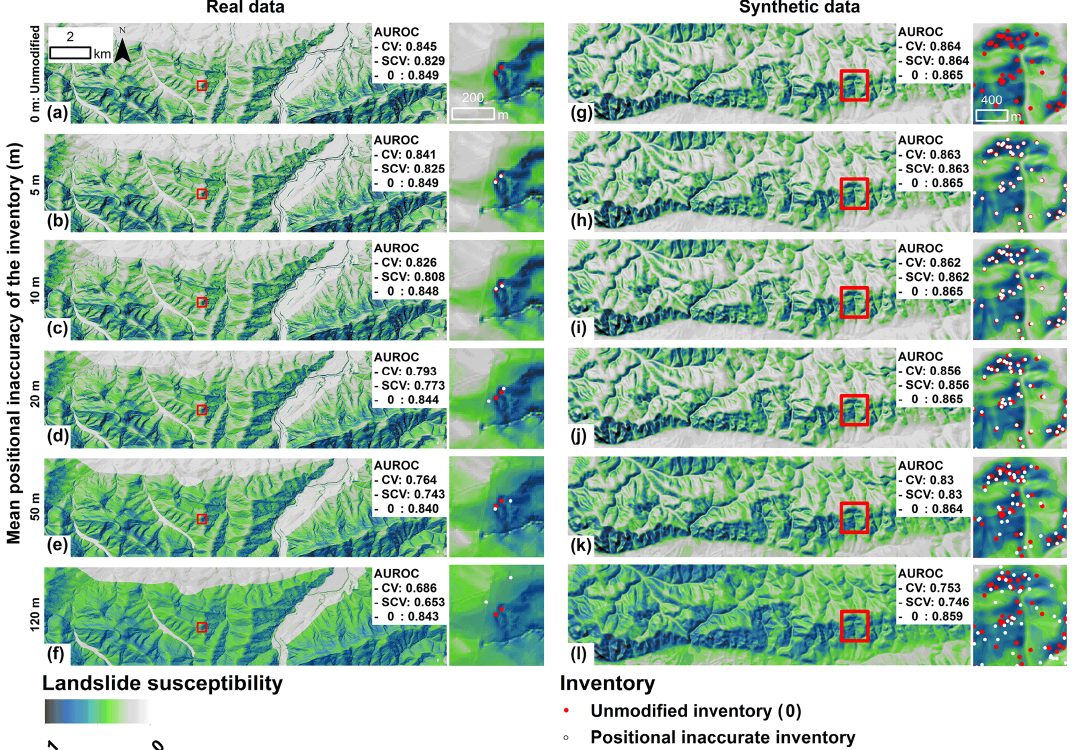
Figure 5. Landslide susceptibility maps (for the location of the cutouts refer to the red boxes) of models generated with differently accurate inventories (rows) for the real data (left column) and the synthetic data (right column). Corresponding predictive performances (median AUROC for CV and SCV) and the quantitative comparison with the original landslide positions (0 in Fig. 5) are given in the respective white boxes. The cutouts additionally show the location of the positionally erroneous inventories (white dots) used as input for the respective models and the position of the original inventory (red dot). Note that maps generated with the most inaccurate inventory (f, l) are characterized by a locally more uniform spatial